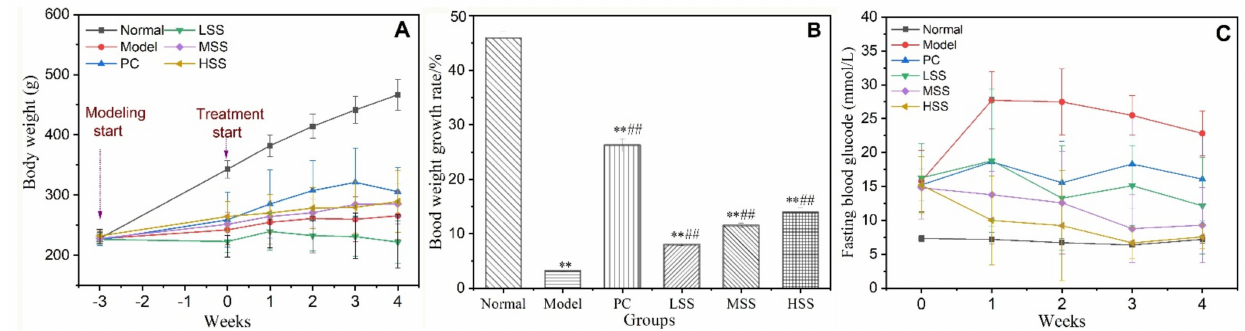
Figure 1. Effects of oral SS administration on the body weights and FBG level of T2D rats. ( A ) Body weights; ( B ) body weight growth rate; ( C ) FBG levels. Normal: normal group; Model: diabetic model group; PC: 0.5% metformin administration; LSS, MSS, and HSS: 1%, 2.5, and 5% SS administration, respectively; n = 10, ** p < 0.01, vs. normal group; ## p < 0.01, vs. model